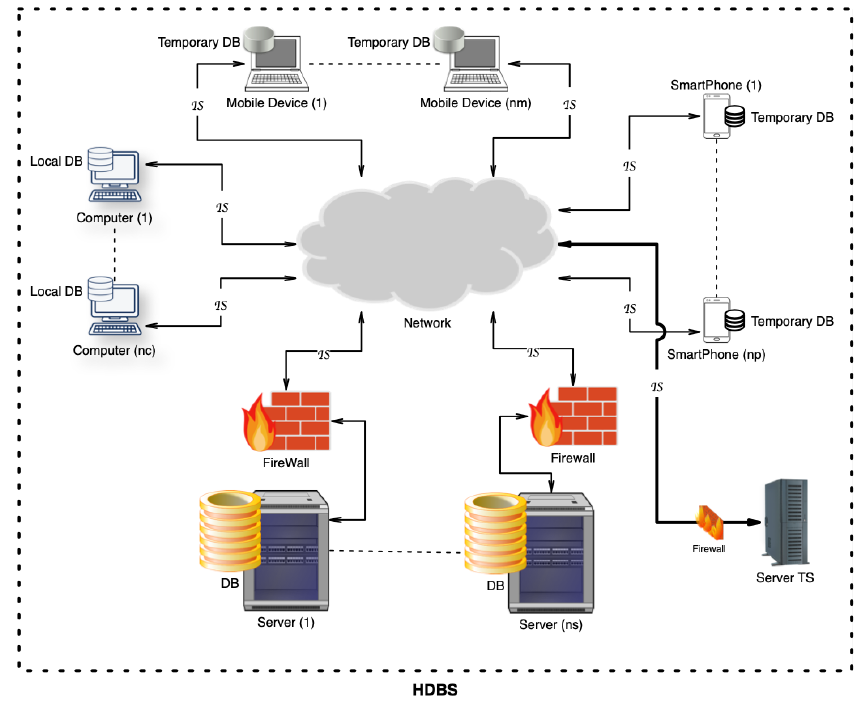
Figure 1. System